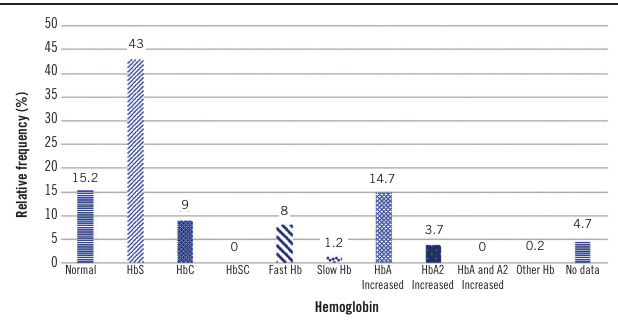
figurE 2 − Hemoglobinopathy frequency Relative frequency for each hemoglobin variant. Every case was confirmed and assigned a pattern after the confirmatory test conducted in affected newborns and parents. The “no data” category corresponds to cases in which an abnormal electrophoretic pattern was obtained and could not be assigned to any Hb variant. The relative frequency (%) was calculated based on positive cases for each hemoglobin variant within the newborn group with confirmation test ( n = 400).